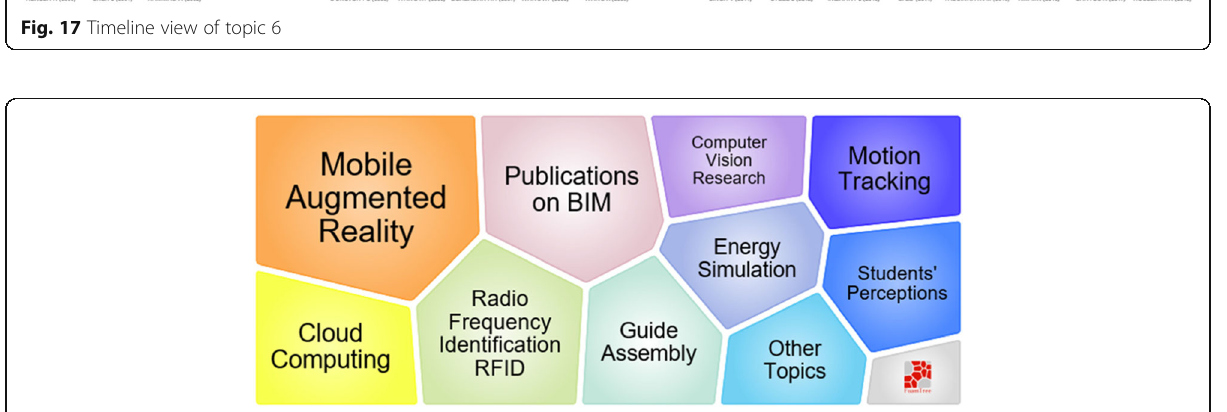
Fig. 17 Timeline view of topic 6